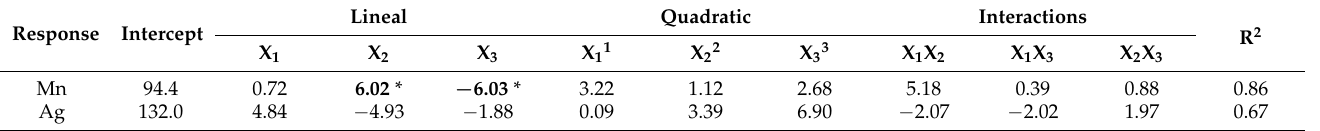
Table 4. Regression coefficients of responses of the bioleaching process (coded